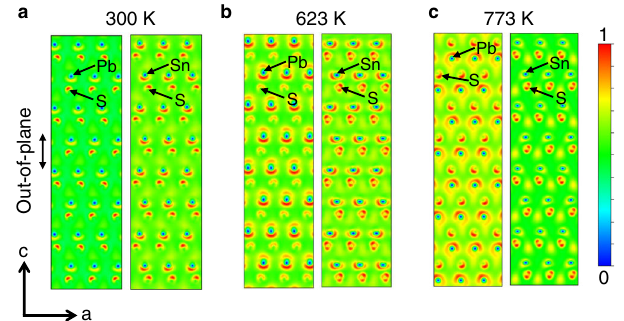
Fig. 3 | Projected interlayer charge densities of the optimal Cl doped PbSnS 2 along [010] direction. a 300K. b 623K. c